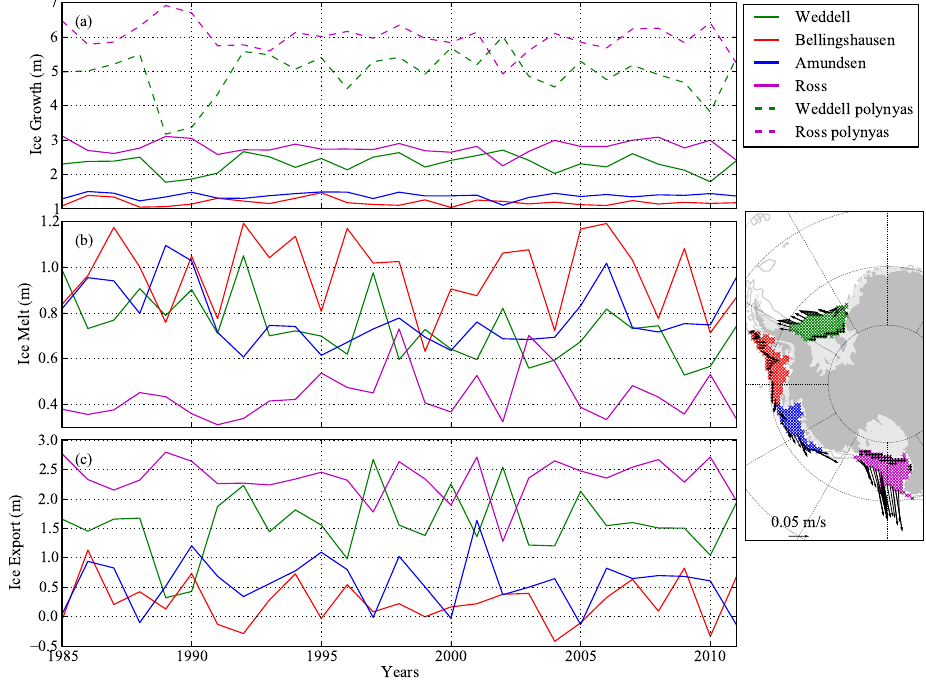
Fig. 13. Annual (1985–2011) regional sea ice mass balance (same regions as Fig. 11). (a) Annual regional ice production, including the contribution from rapid sea ice growth “polynya” grid cells (marked by the black crosses) , (b) annual regional ice melt, (c) annual regional net ice export. Mean ice motion vectors for the outer grid cells of each region are shown in the map.